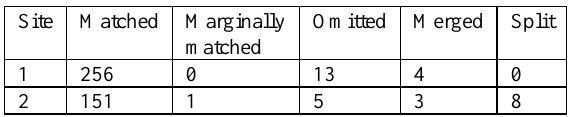
Table 1: The accuracy statistics of the delineation tree crowns using U-net for test sites 1 and 2. The total number of reference crowns are 273 and 168 for these two sites, respectively. The delineated tree crowns obtained by Residual U-net for these two plots are shown in Figures 7 and 8, respectively and the quantitative statistics is shown in Table